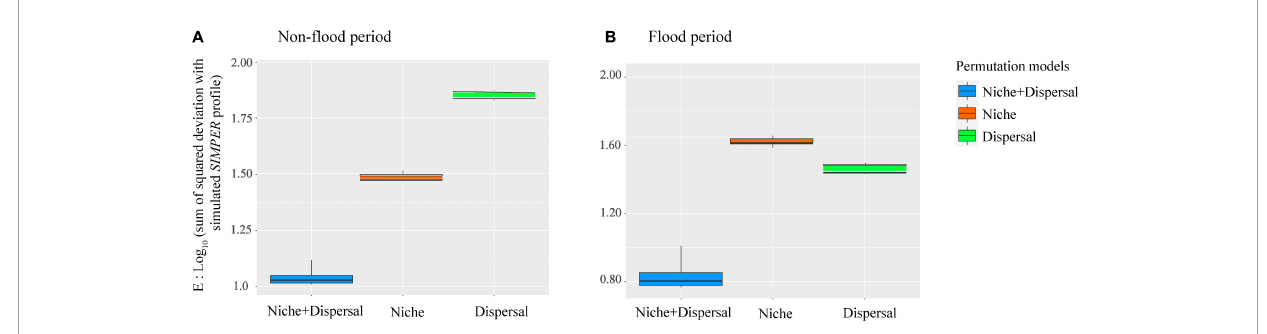
FIGURE7 PER-SIMPER analysis revealing the relevance of niche-based and stochastic processes for phytoplankton community assembly “during the (A) non-flood and (B) flood periods” in the study area. The lower the E value, the closer the simulated profile to the empirical simper model.